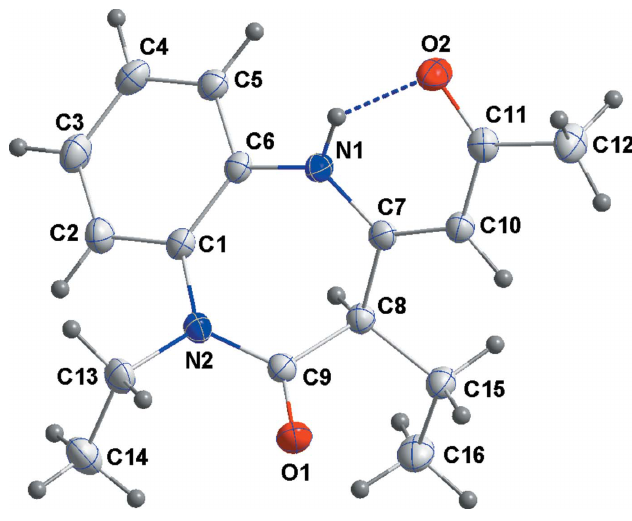
Figure 1 The title molecule with 50% probability ellipsoids.